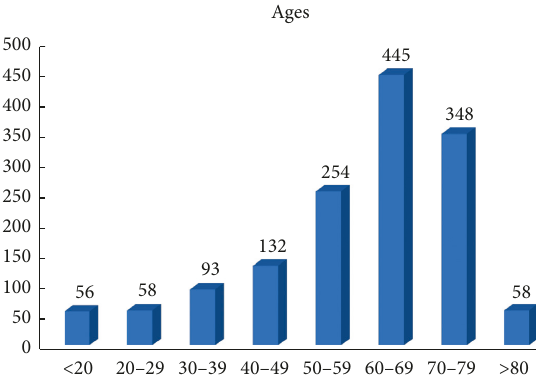
Figure 1: Ages of the patients. The numbers on top of the bars represent the patient counts in each age range category.